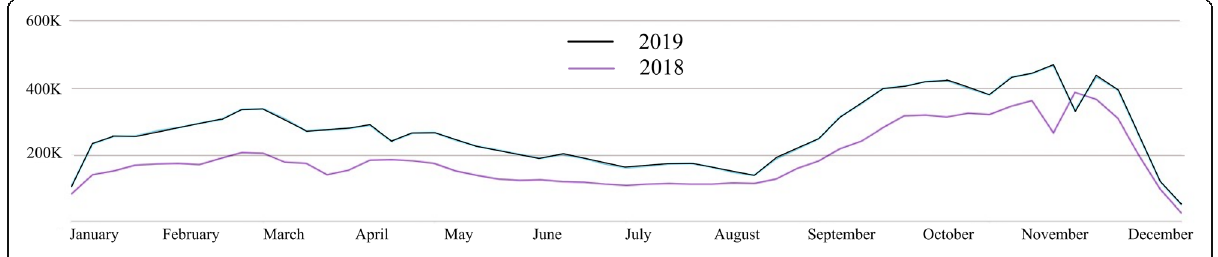
Fig. 2 Comparison of video views for 2018 (purple) and 2019 (black)